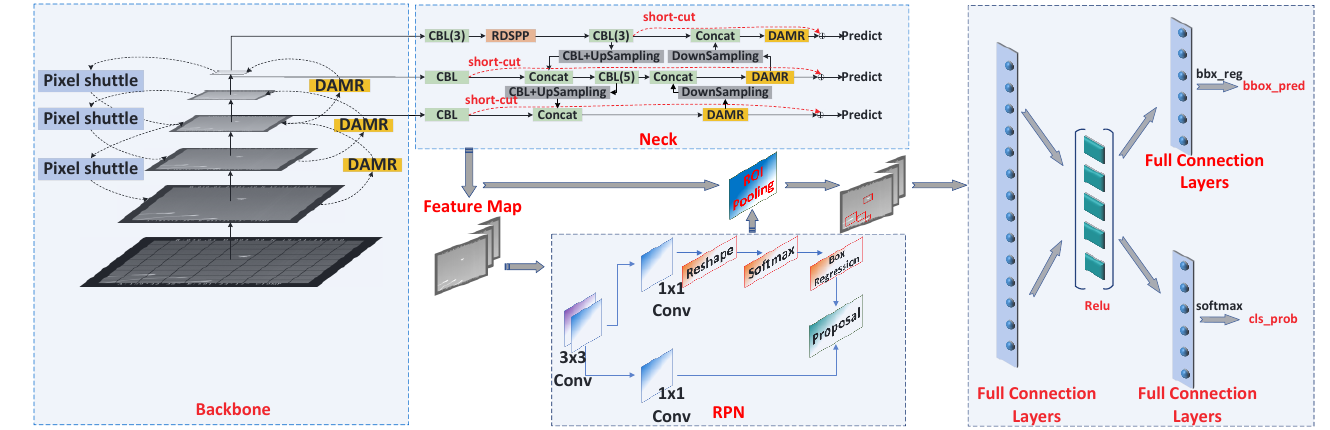
Figure 4. The overall framework of MSFE. The feature extraction of the key frame introduces the dual-channel dilated convolu- tional block attention [38] module integrated with Resblock (DAMR) into the backbone feature extraction network and adopts the structure of SCFPN. The feature extraction network structure of the key frame is shown in Figure 5.